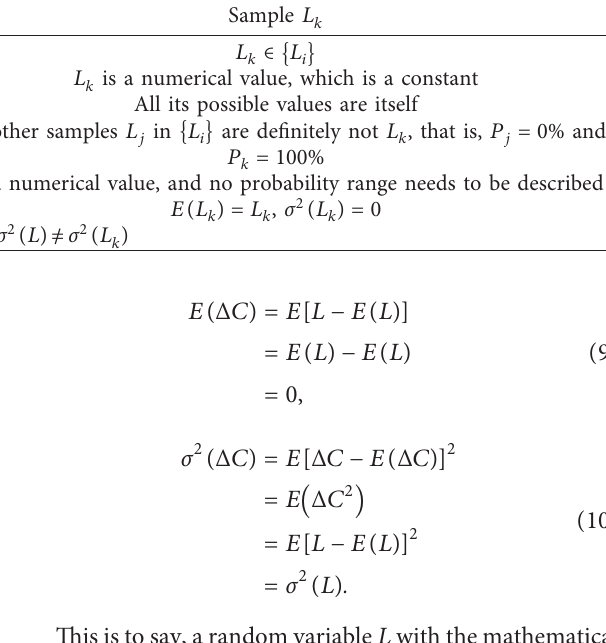
Table 1: The conceptual differences between the random variable and the